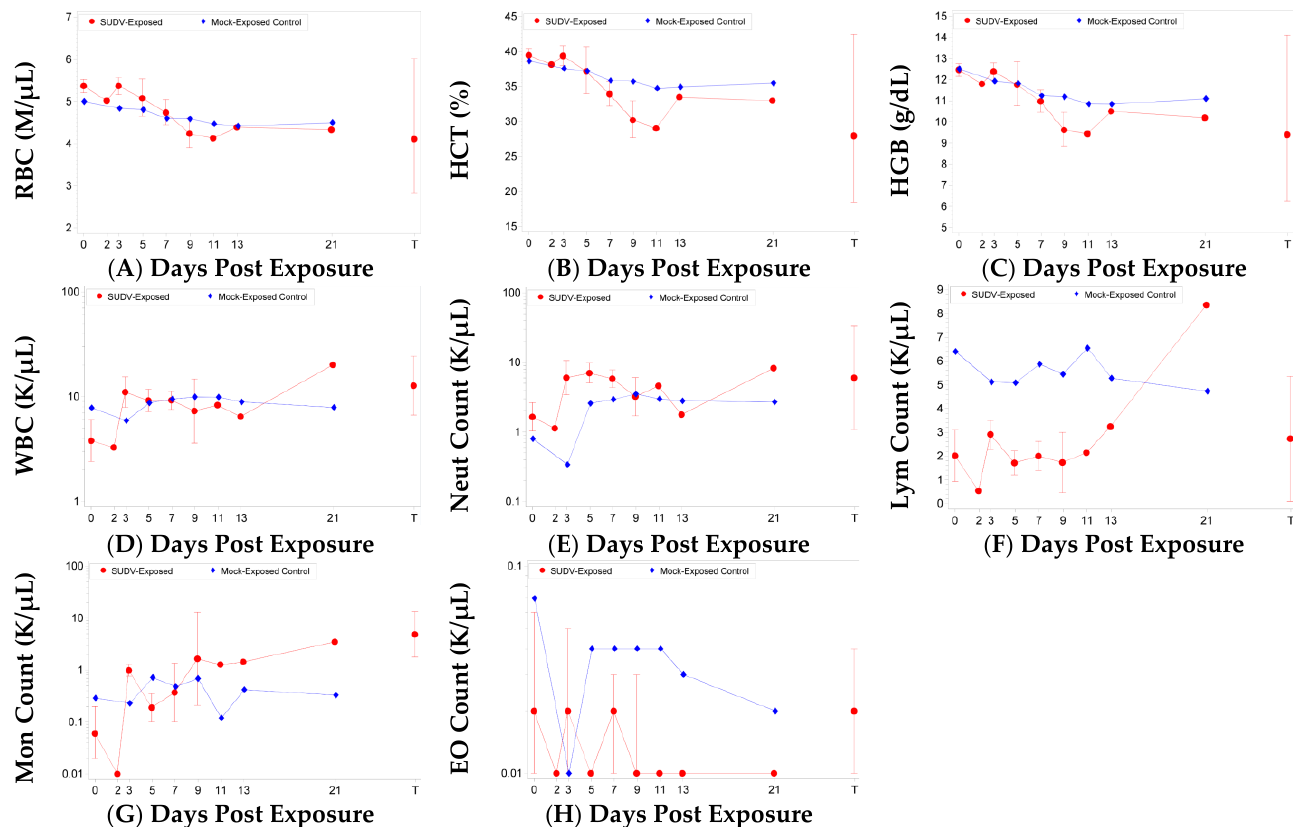
Figure 2. Hematology parameters in SUDV-exposed and mock-exposed cynomolgus macaques. Mean with 95 percent confidence intervals; confidence interval was not plotted for sample size less than 3. Unless otherwise noted, values were log-transformed and the geometric mean is displayed. T represents Terminal (data collected from animals that met euthanasia criteria were combined and reported as a single terminal time point). ( A ) Red blood cell counts. ( B ) Hematocrit. ( C ) Hemoglobin. ( D ) White blood cells. ( E ) Neutrophils. ( F ) Lymphocytes. ( G ) Monocytes. ( H ) Eosinophils. For ( A – C ), the 95 percent confidence intervals are not symmetric because geometric confidence bounds are displayed on a linear scale.